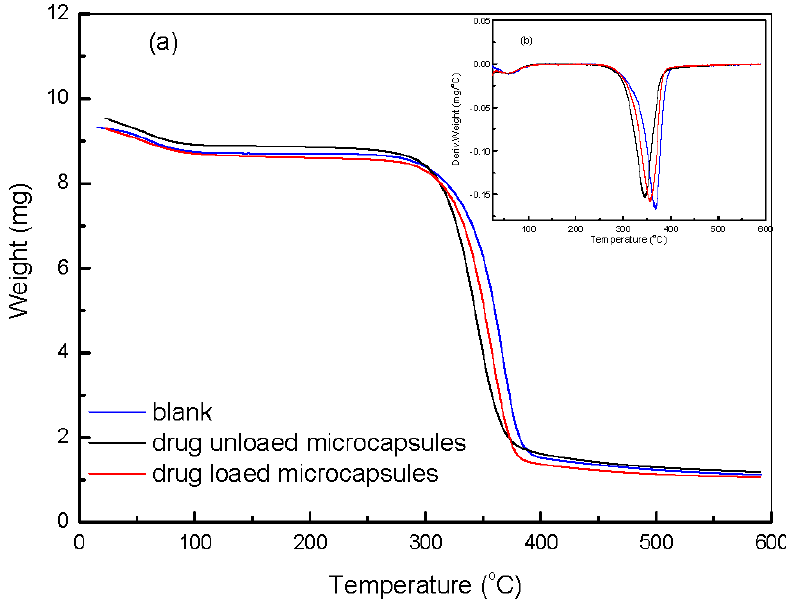
Figure 7. Thermogravity of hydrogel microcapsules loaded paper ( a ) and first derivative curve ( b ).